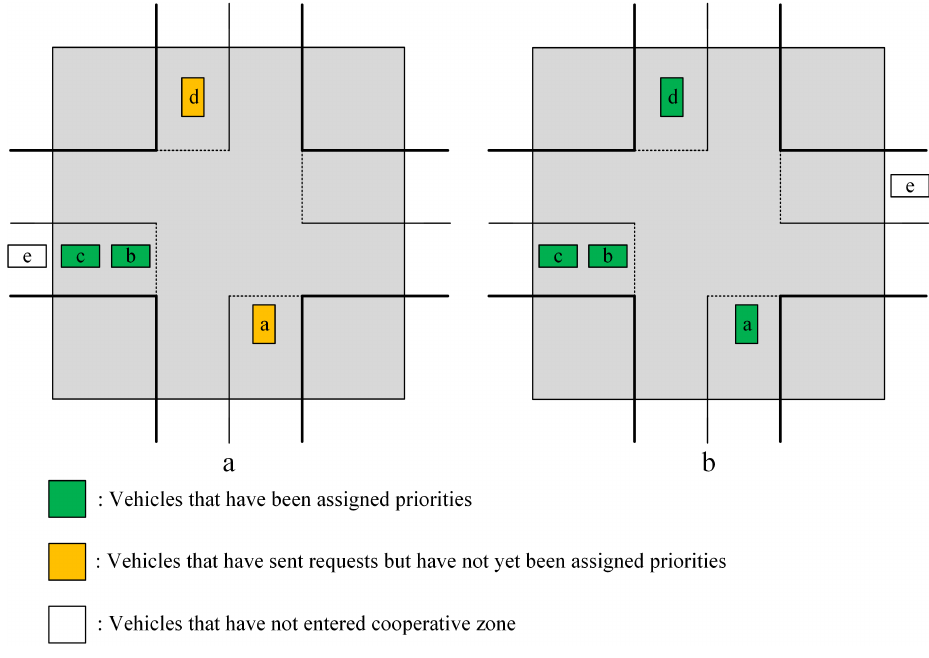
Figure 5. An example of selecting different actions. ( a ) Agent selects an action to let vehicles in a specific lane to pass. ( b ) Agent selects the action to let all vehicles that have sent requests to